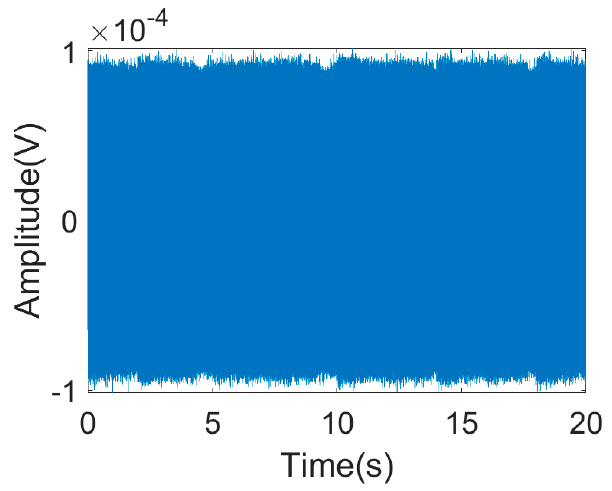
Figure 8. The output with a nondirectional antenna.